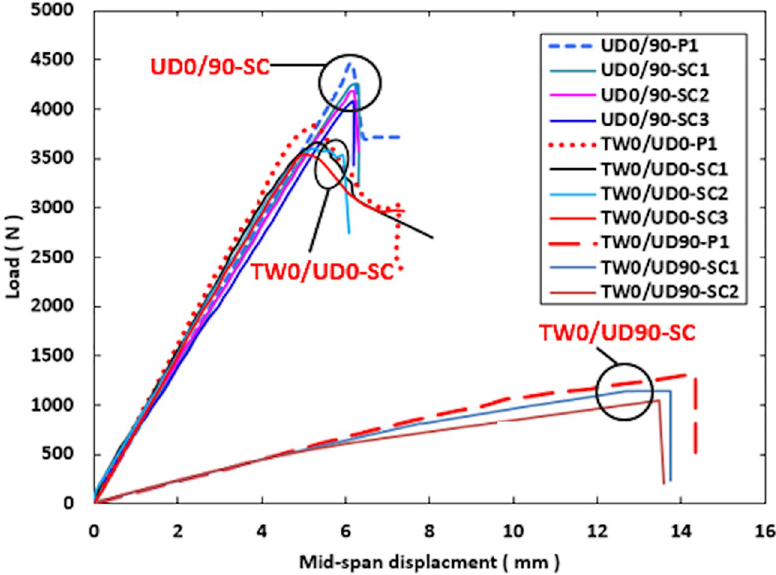
Fig 8. Load against mid-span displacement curve for crack-free SHC beams and those containing pre-existing 10 mm transverse top skin crack at shear span.